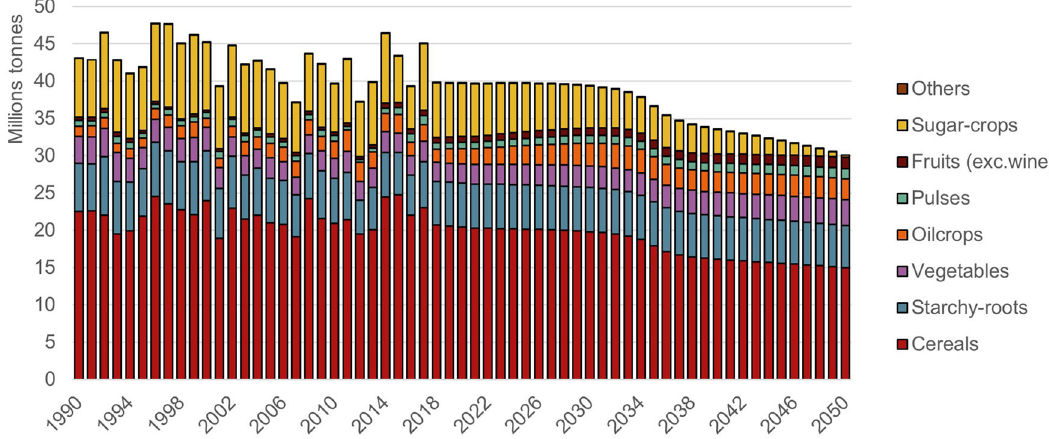
Fig. 3 Evolution of the crop production in the UK from 1990 to 2050 in the EEB pathway (tonnes) 1,27,43 . The food groups have been aggregated for a better visibility.